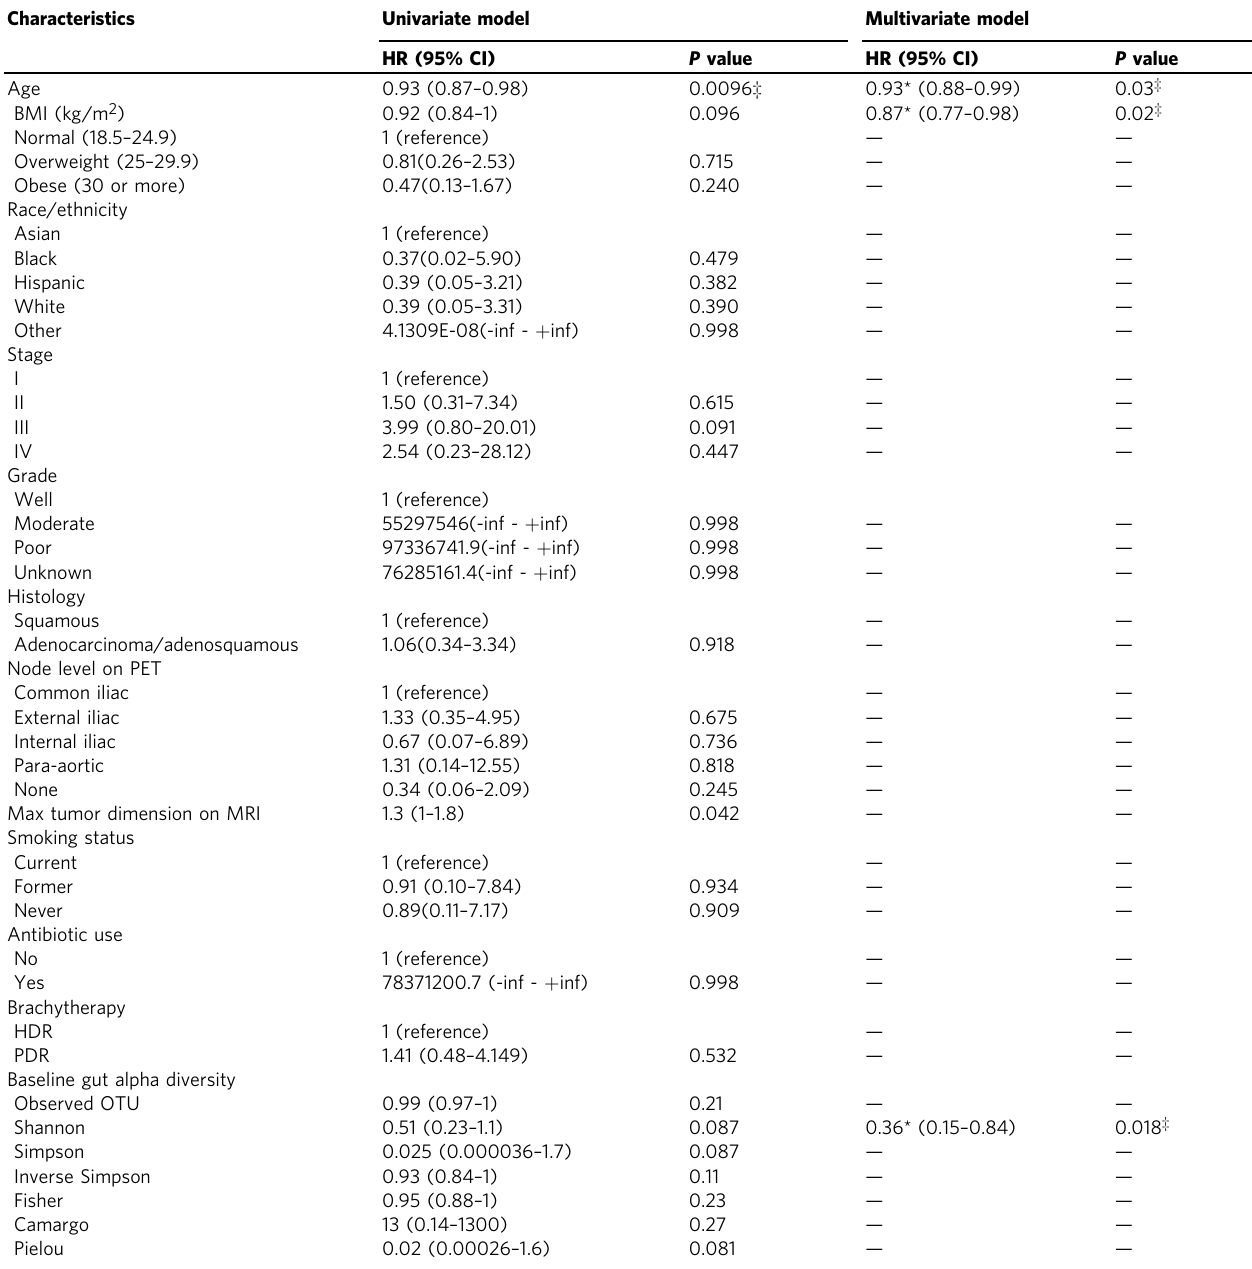
Table 1 Univariate and multivariate Cox regression analysis for recurrence-free